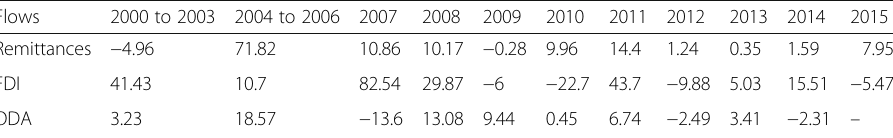
Table 1 Percentage growth of Remittances and other monetary flows in Sub-Sahara African countries